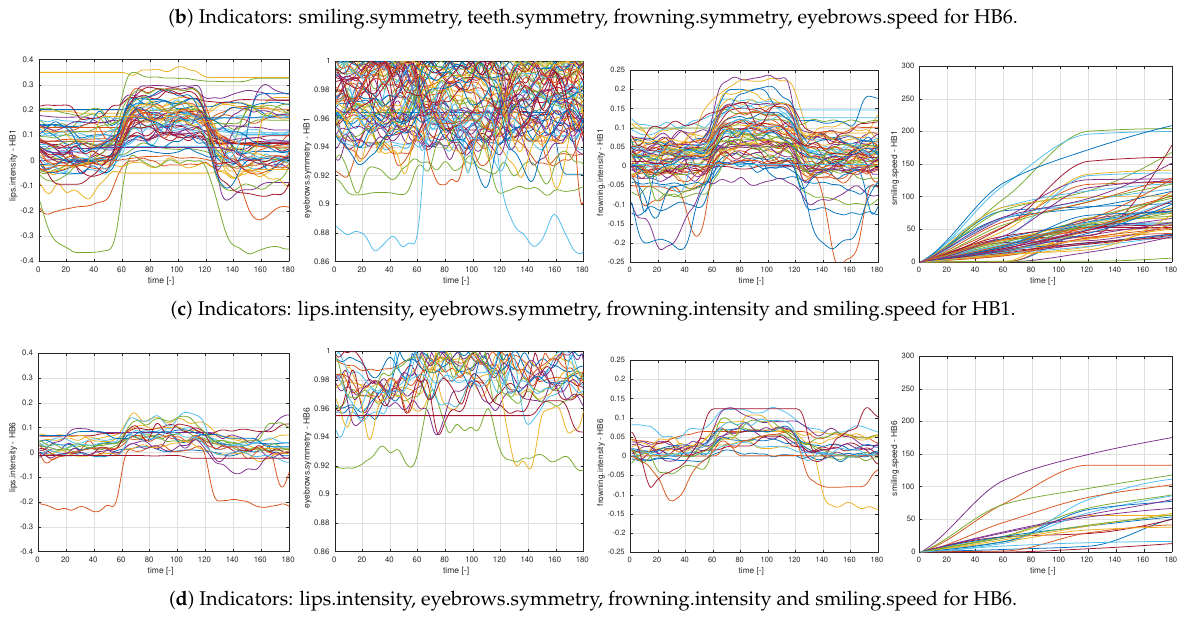
Figure 7. Indicators selected by the stepwise variable selection procedure.